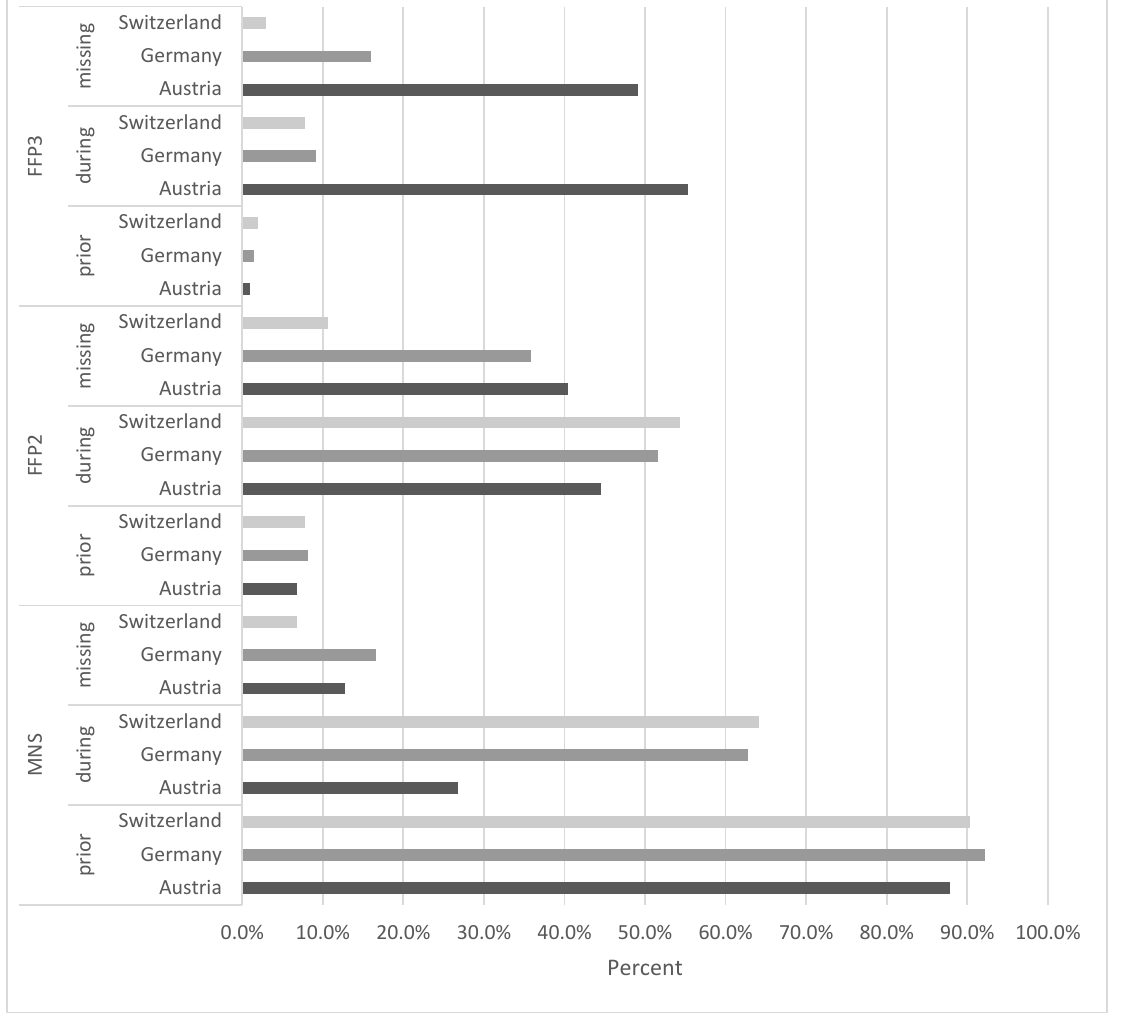
Figure 2. The standard use of protective masks (MNS = surgical masks, FFP2 (filtering facepiece) masks, FFP3 masks) prior to the COVID-19 pandemic, during the first peak of infections, and missing protective masks at the first peak of the COVID-19 pandemic.